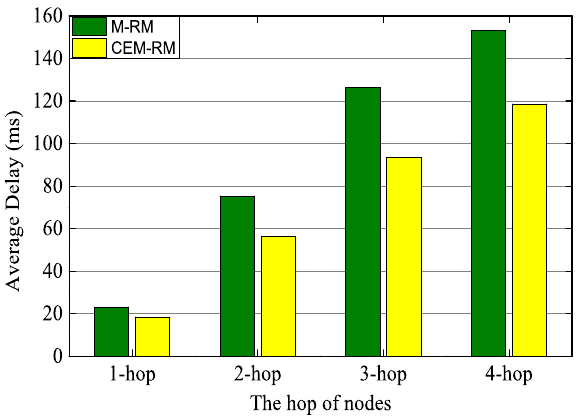
Figure 13. Comparison of average end-to-end delay between CEM-RM and